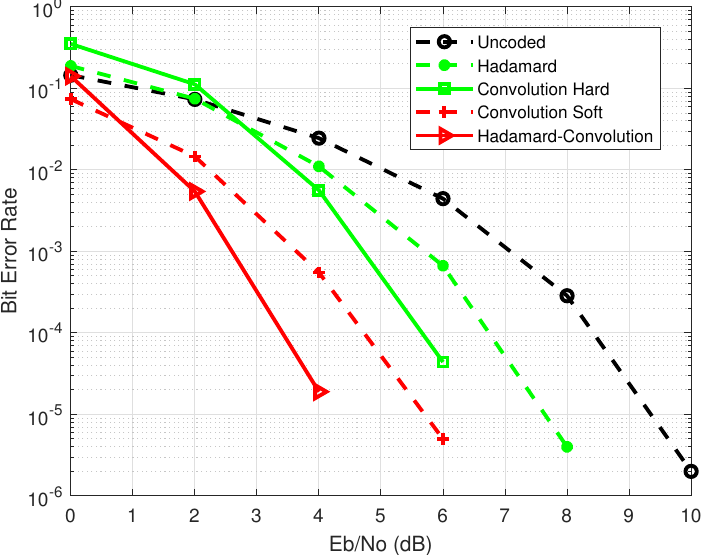
Figure 6. Bit error rate performance comparisons of multiple decoding methods in multipath